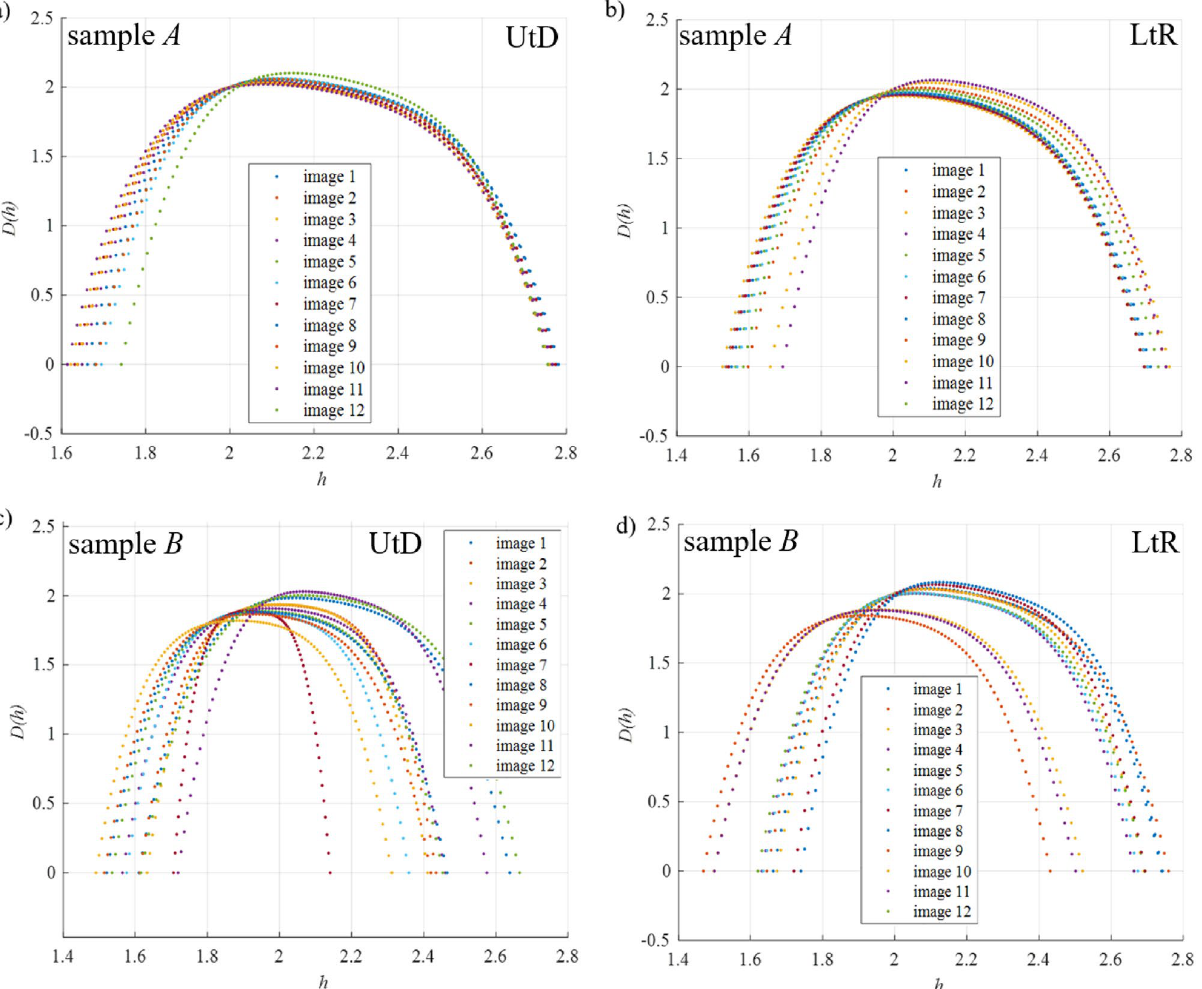
Figure 1. Singularity spectra obtained for sample A (SiO 2 in demineralized water): ( a ) the direction of the UtD (Up to Down) images; ( b ) direction of the LtR (Left to Right) images and sample B (SiO 2 in isopropanol): ( c ) direction of the UtD images; ( d ) direction of the LtR